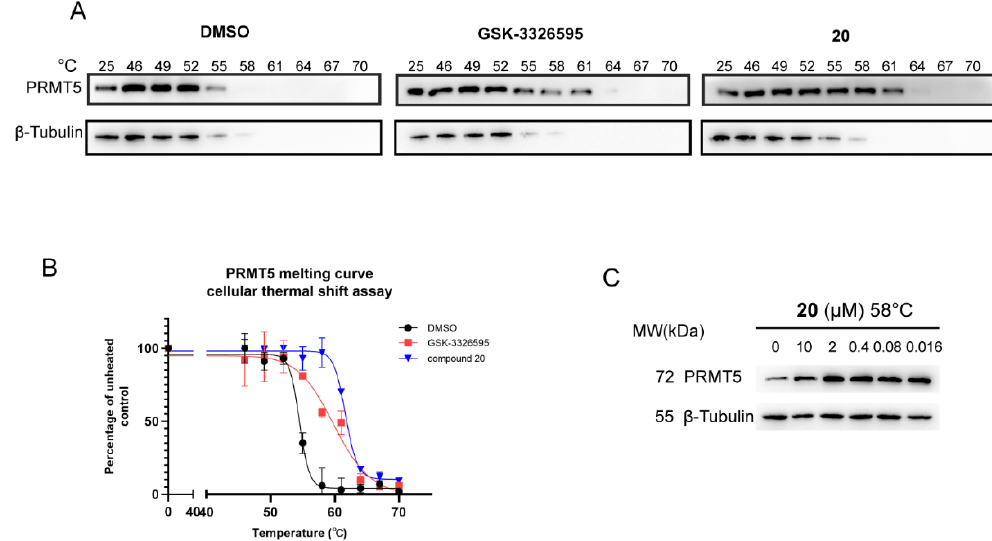
Figure 4. ( A ) MV-4-11 cell lines were treated for 18 h with 1 μ M GSK-3326595, and compound 20 showed stabilization of PRMT5 in cellular thermal shift analysis in whole-cell lysates. ( B ) The relative strength of PRMT5 signal on the Western blots was measured by densitometry. The melting temperature for PRMT5 was shifted by 5.5 °C and 7.2 °C. All data were analyzed using a Boltzmann sigmoidal fit. Each point plotted represents the mean of three replicates for each temperature; error bars denote ± SD. ( C ) The binding of 20 inhibits the degradation of PRMT5 at 58 ◦ C in a dose-dependent manner.